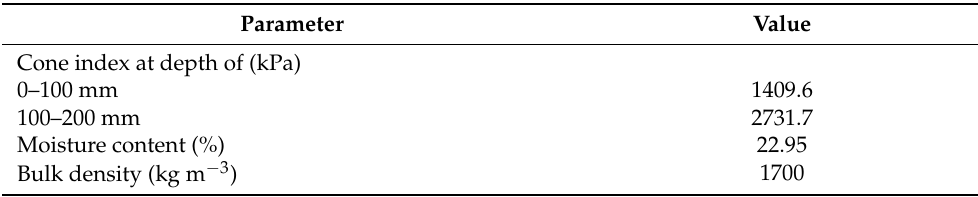
Table 1. Soil properties of the pre-tillage condition in the experiment field. Parameter Value Cone index at depth of